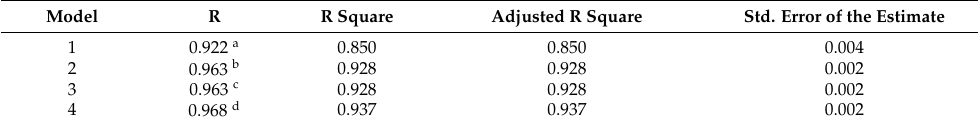
Table A1. Model Summary e .